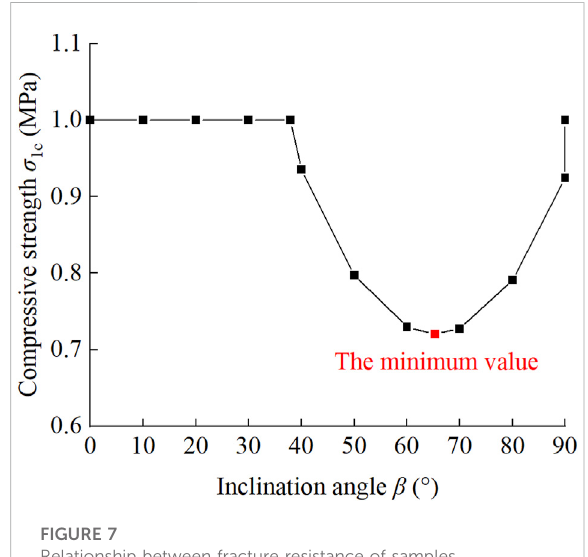
FIGURE 7 Relationship between fracture resistance of samples containing opening fl aws and inclination